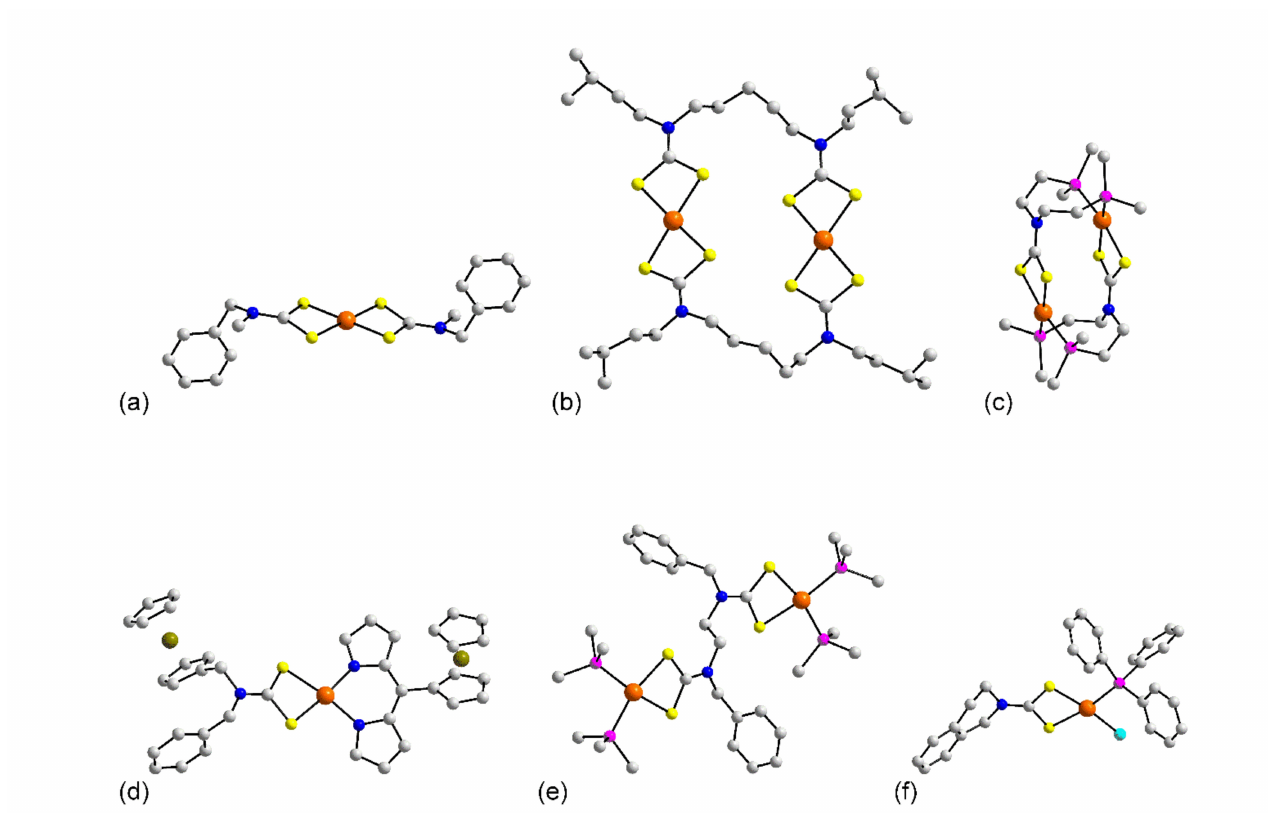
Figure 8. Molecular structures of palladium complexes: ( a ) Pd( L 13 ) 2 ( 81 ), ( b ) Pd 2 ( L 86 ) 2 in the crystal of 100 , ( c ) [Pd 2 ( L 44 ) 2 ] 2+ in 102 , ( d ) (fcdpm)Pd( L 43 ) ( 105 ), ( e ) {[(PPh 3 ) 2 Pd] 2 ( L 85 )} 2+ in 113 , and ( f ) (PPh 3 )Pd( L 81 )Cl in 122 . In ( c , e ), only the ispo-C atoms of the phosphane bound phenyl rings are shown for